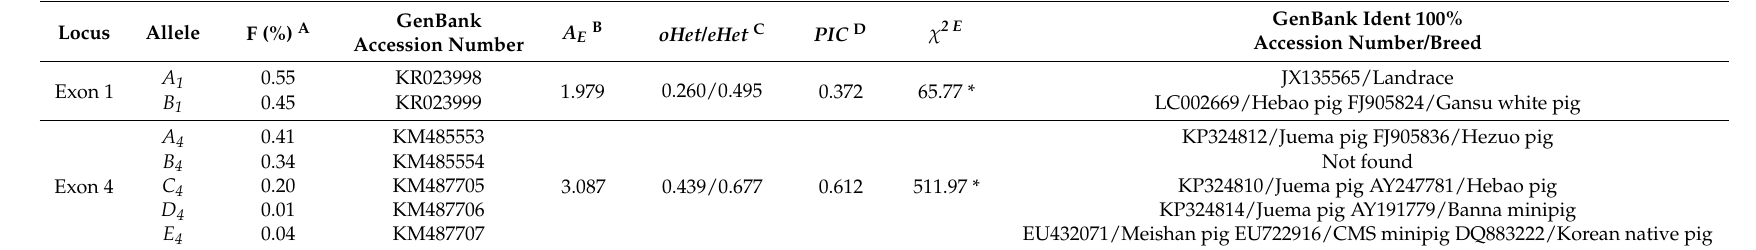
Table 2. Frequencies and genetic polymorphism parameters of SLA-DRA exons alleles in Yantai black pigs. Locus